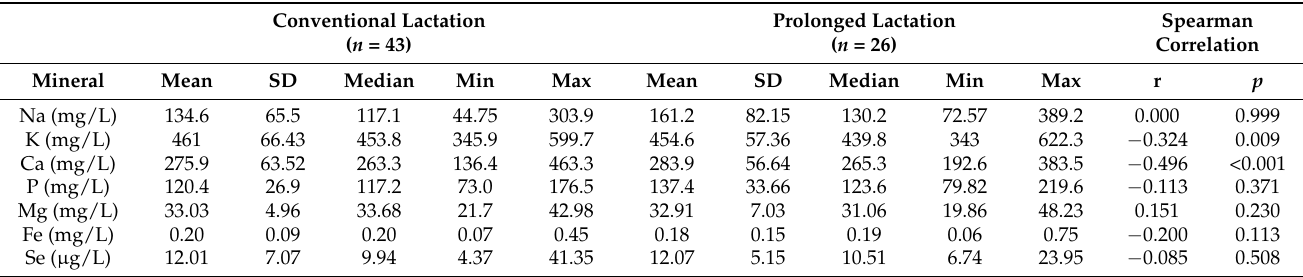
Table 5. Mineral levels in Spanish breast milk during conventional (<6 months, n = 43) and prolonged ( ≥ 6 months, n = 26) lactation; correlations between lactation time and mineral